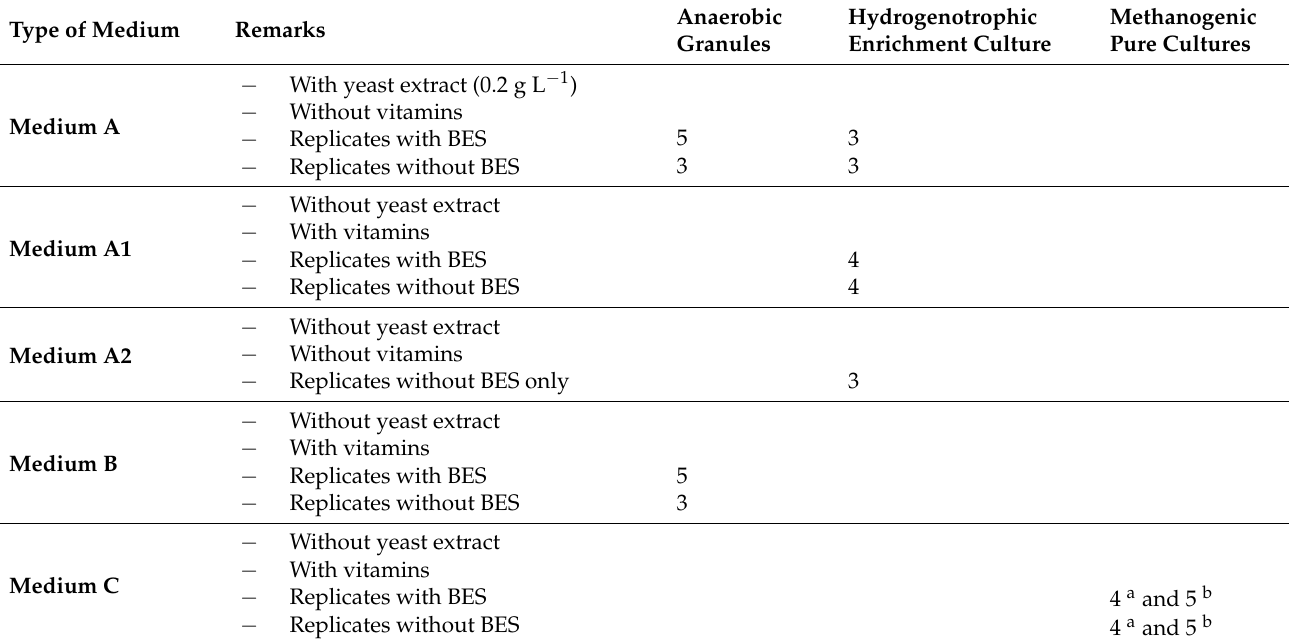
Table 1. Major features of the mineral media used for the tested